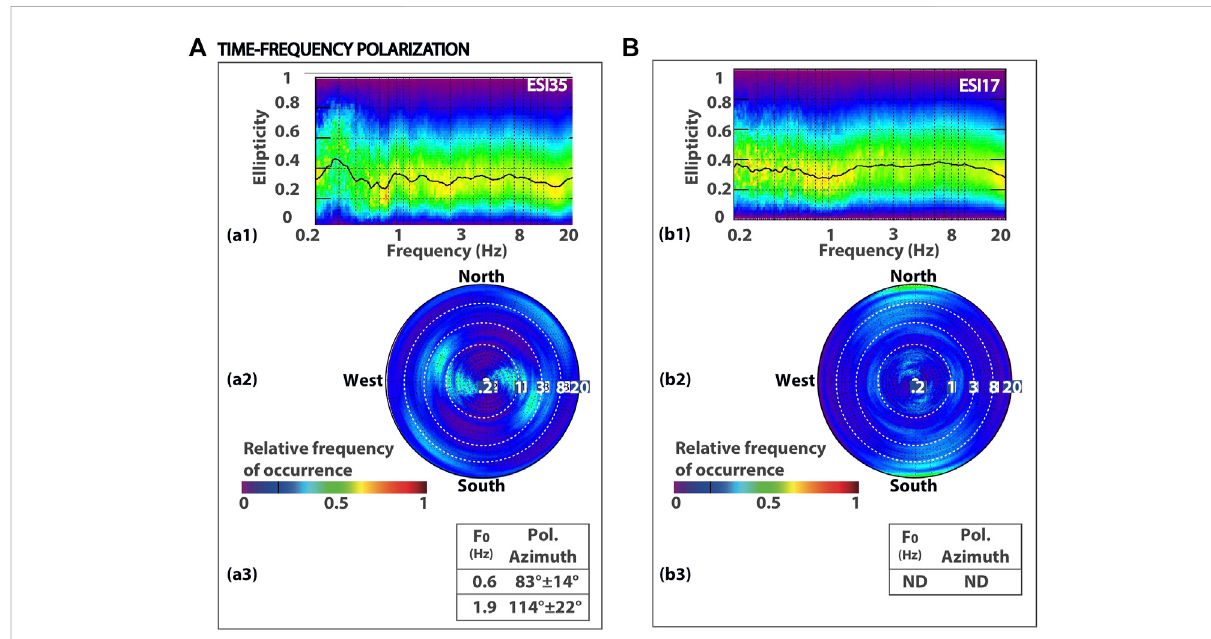
FIGURE 4 Results for time – frequency polarization analysisatstationsESI35 (A) and ESI17 (B) . In panels a1 and b1, we show ellipticity versus frequency. It is de fi nedastheratiobetweenthelengthoftheminorandmajoraxesandapproaches0whengroundmotionislinearlypolarized.Inpanelsa2andb2, polarization azimuth values obtained from all over the time series analyzed are cumulated and graphed using polar plots where the contour scale represents the relative frequency of occurrence of each value, and the distance to the center represents the signal frequency in Hz. Dashed circles depict frequencies of 1 Hz, 3 Hz, and 8 Hz. Finally, in panels a3 and b3, a summary of obtained results is